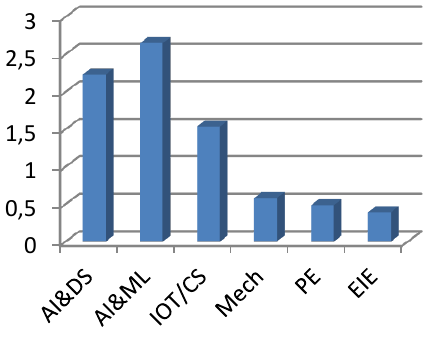
Figure 7: Ranks of